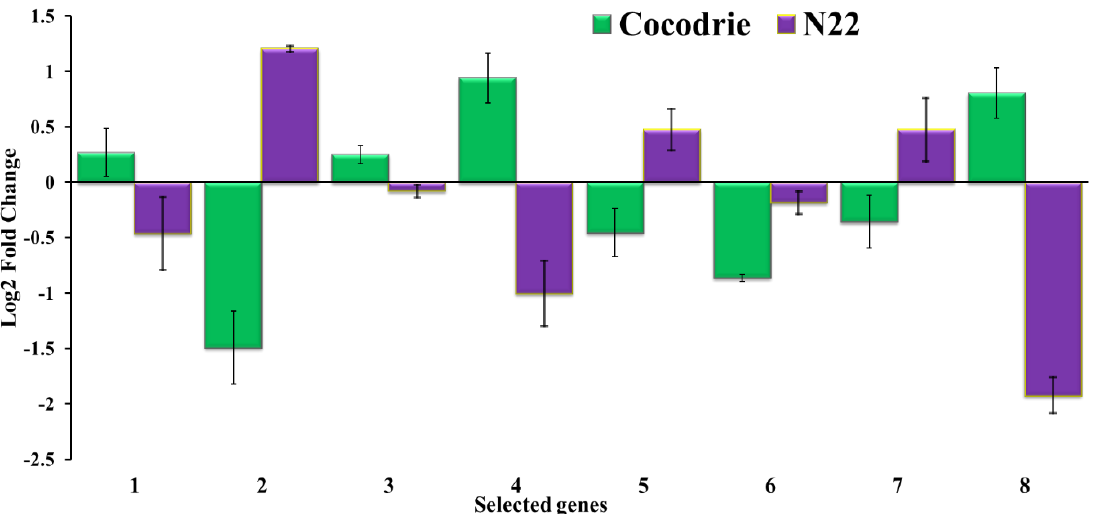
Figure 5. Expression profiles of eight selected genes present in the alkalinity tolerance QTL regions under alkalinity stress (6 h after imposition of stress) in Cocodrie and N22. The selection was based on differences in high-impact variants between the parents. Selected genes included: 1- LOC_Os10g35040 (receptor kinase-like protein); 2-LOC_Os10g34000 (aquaporin protein); 3- LOC_Os10g35170 (semialdehyde dehydrogenase, NAD-binding domain-containing protein); 4- LOC_Os10g33970 (double-stranded RNA-binding motif-containing protein); 5-LOC_Os09g32550 (glucan endo-1,3-beta-glucosidase precursor); 6-LOC_Os09g32860 ( OsFBX335 -F-box domain-con- taining protein); 7-LOC_Os08g01560 (expressed protein); and 8-LOC_Os08g01720 (expressed pro- tein). EF1α was used as the reference gene and gene expressions were expressed as log2 fold changes under alkaline stress compared with control in both parents.